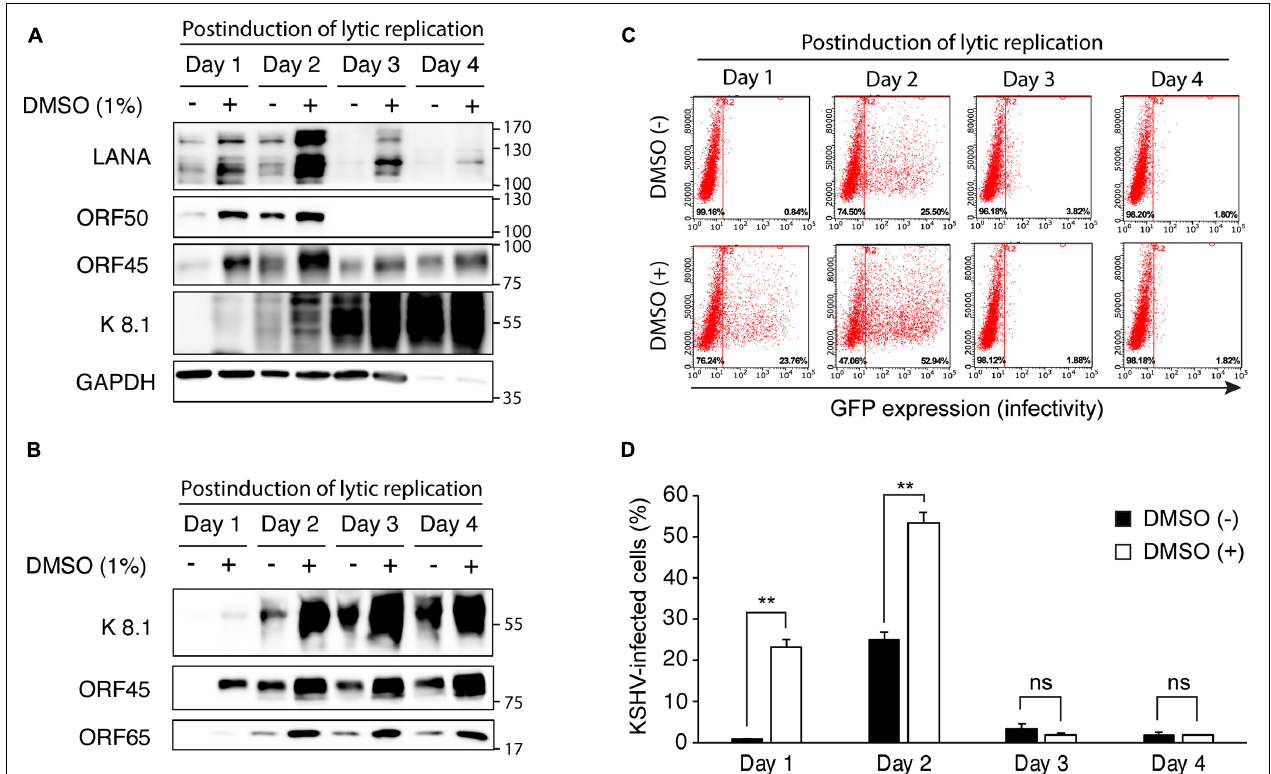
FIGURE 5 | Time kinetic analysis of changes in viral gene expression and virus production of KSHV by DMSO treatment during reactivation of KSHV. (A) Western blot analysis for KSHV gene expression in iSLK BAC16 cells with DMSO. iSLK BAC16 cells were treated with DMSO and inducing agents for lytic replication together, then analyzed indicated viral proteins. (B) Western blot analysis of KSHV proteins of the isolated KSHV from iSLK BAC16 cells. After induction of lytic replication, KSHV was extracted from the supernatants of iSLK BAC16 cells at the indicated time points. The same volume of extracted KSHV from each experimental condition was analyzed. (C,D) The flow cytometric analysis of GFP expression in KSHV-infected HUVECs. The isolated KSHV from each condition infected with HUVECs, followed by analyzing GFP expression by flow cytometry at 24 h after infection. Representative results of the flow cytometric analysis of GFP expression in KSHV-infected HUVECs (C) . Analysis of KSHV infectivity (D) . Data are shown as the mean ± SD, n = 3, and ** p < 0.01. ns, not